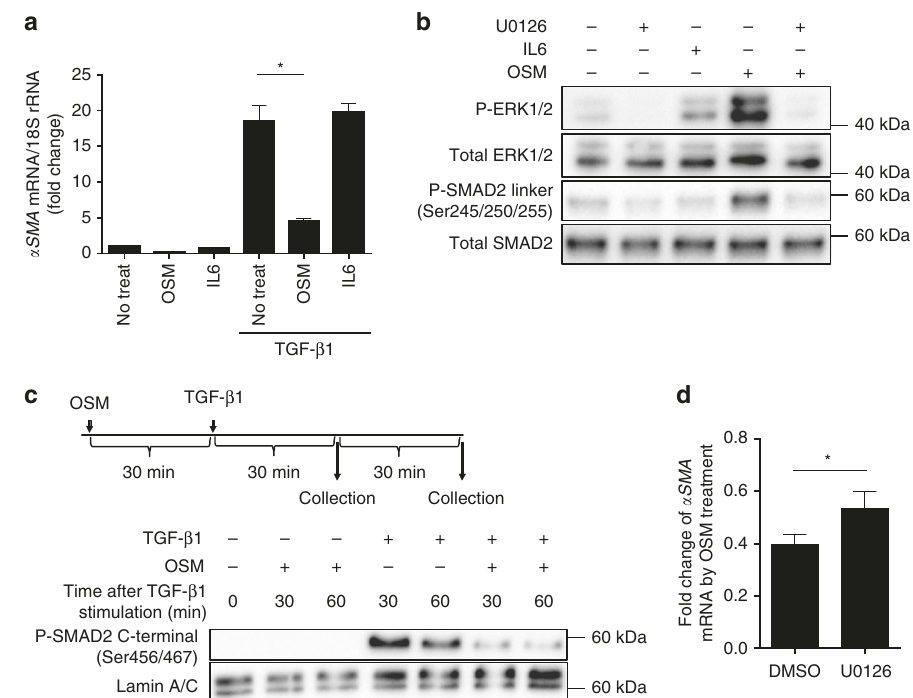
Fig. 5 OSM suppresses SMAD signaling. a After pretreatment with the OSM (10 ng per ml) or IL6 (20 ng per ml), C3H/10T1/2 cells were stimulated with TGF- β 1 (2.5 ng per ml, 12 h) and the relative expression level of α SMA mRNA was calculated. The one-way ANOVA and Dunnett ’ s multiple comparisons test were used for the statistical analysis (F (2, 6) = 97.35). b Immunoblot analysis of phospho-ERK1/2, total ERK1/2, phospho-SMAD2 linker (Ser245/ 250/255) and total SMAD2 protein. Thirty minutes after U0126 (20 nM) pretreatment, C3H/10T1/2 cells were stimulated with OSM (10 ng per ml) or IL6 (20 ng per ml) for 30 min. and collected for the analysis. U0126: a selective MEK1/2 inhibitor. c Immunoblot analysis of phospho-SMAD2 C-terminal (Ser465/467) and Lamin A/C. Thirty minutes after OSM (10 ng per ml) pretreatment, C3H/10T1/2 cells were stimulated with TGF- β 1 (2.5 ng per ml, 12 h) and collected at indicated time points. d After pretreatment with U0126 (20 μ M, 60 min) and OSM (10 ng per ml, 30 min), C3H/10T1/2 cells were stimulated with TGF- β 1 (2.5 ng per ml, 12 h) and the relative expression level of α SMA mRNA was calculated. Two-tailed t -test with Welch ’ s correction was used for the statistical analysis (t = 3.212, df = 3.172). Data show the mean and the standard deviation (error bar) of technical triplicates from a representative experiment ( a , d ). * p <